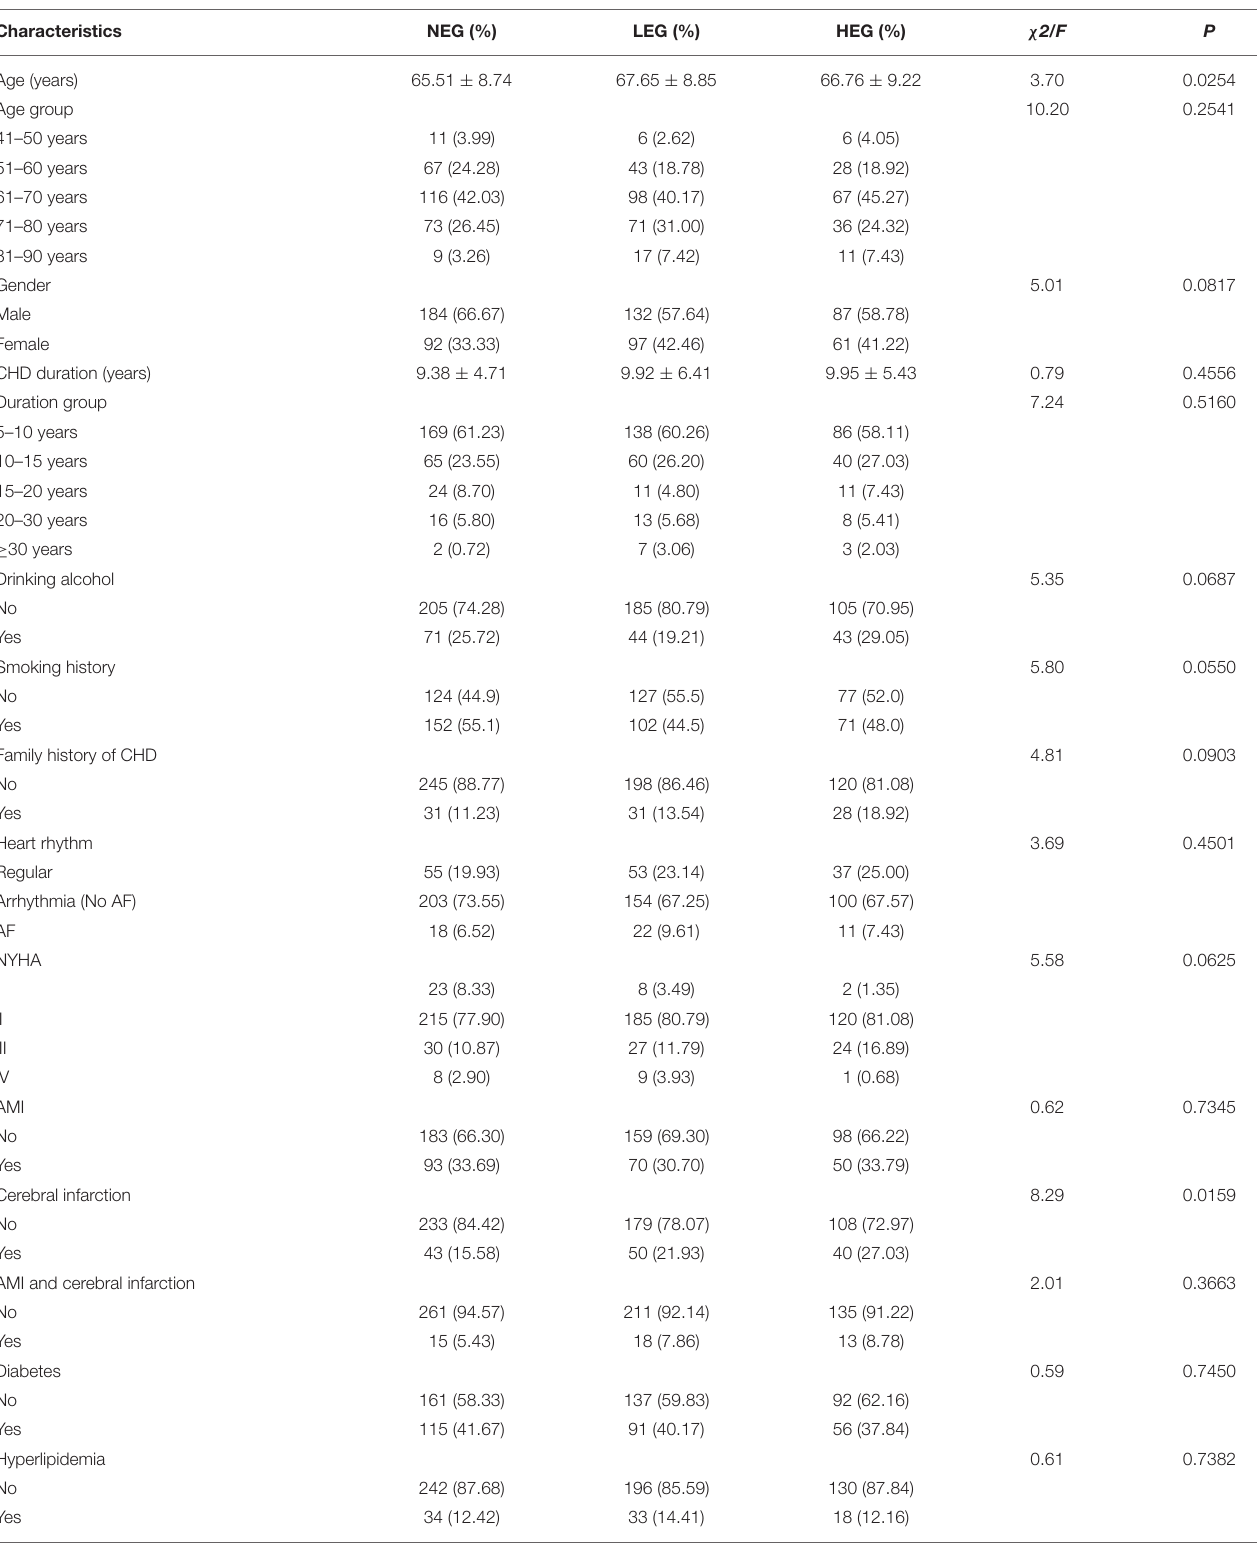
TABLE 1 | Baseline characteristics of the study participants in the cohort study ( n = 653).